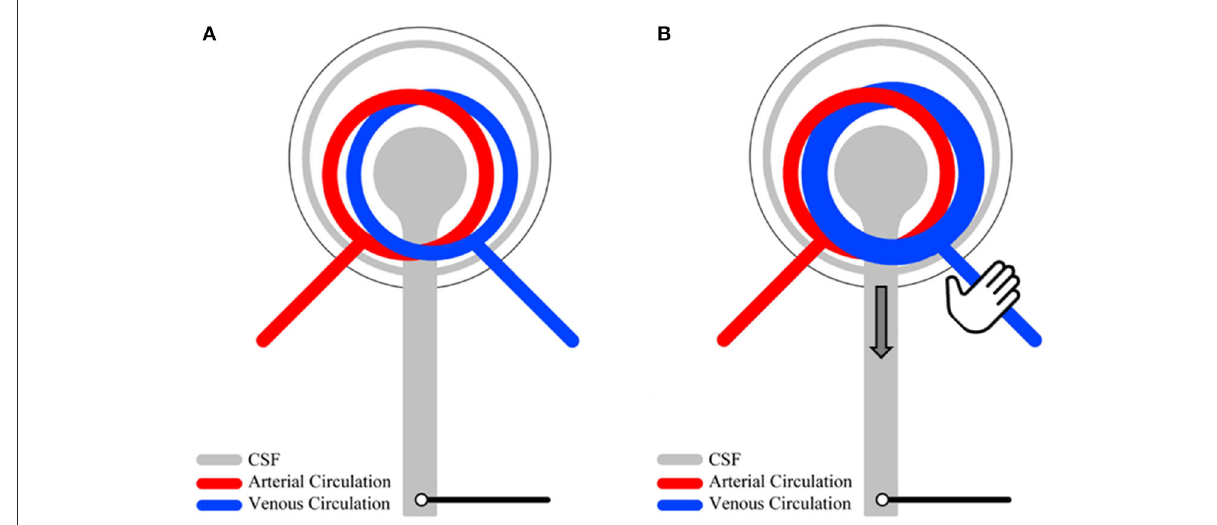
FIGURE1 An overview of CSF pressure (CSFP) dynamics. Under physiological resting-state conditions, lumbar cardiac-driven CSFP peak-to-trough amplitude (CSFPp) is a function of intracranial venous filling and arteriolar pulsations (A) . During the Queckenstedt’s test, intracranial venous filling is temporally increased due to reduced venous outflow, leading to an increased baseline CSFP and increased CSFPp (B) .